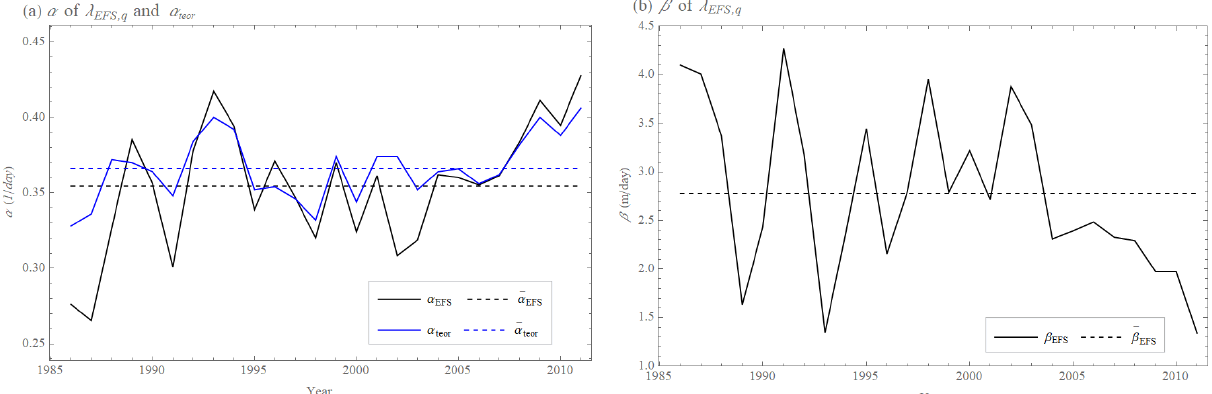
Figure 7. Values of parameters α (a) and β (b) of the extended quadratic model λ q (E) approximated from annual averages of the error growth rate λ EFS (E) of the ECMWF forecasting system’s 500hPa geopotential height values (Northern Hemisphere, 20–90 ◦ ) calculated as differences between two operational forecasts issued with 1d lag but valid on the same day (black), the average value of parameters α EFS = 0.35 ± 0.04d − 1 and β EFS = 2.8 ± 0.9md − 1 over all years (black, dashed) and theoretical value of α teor (blue) and its average value α teor = 0.37 ± 0.02d − 1 (blue, dashed) over all years determined by Bednáˇr et al.